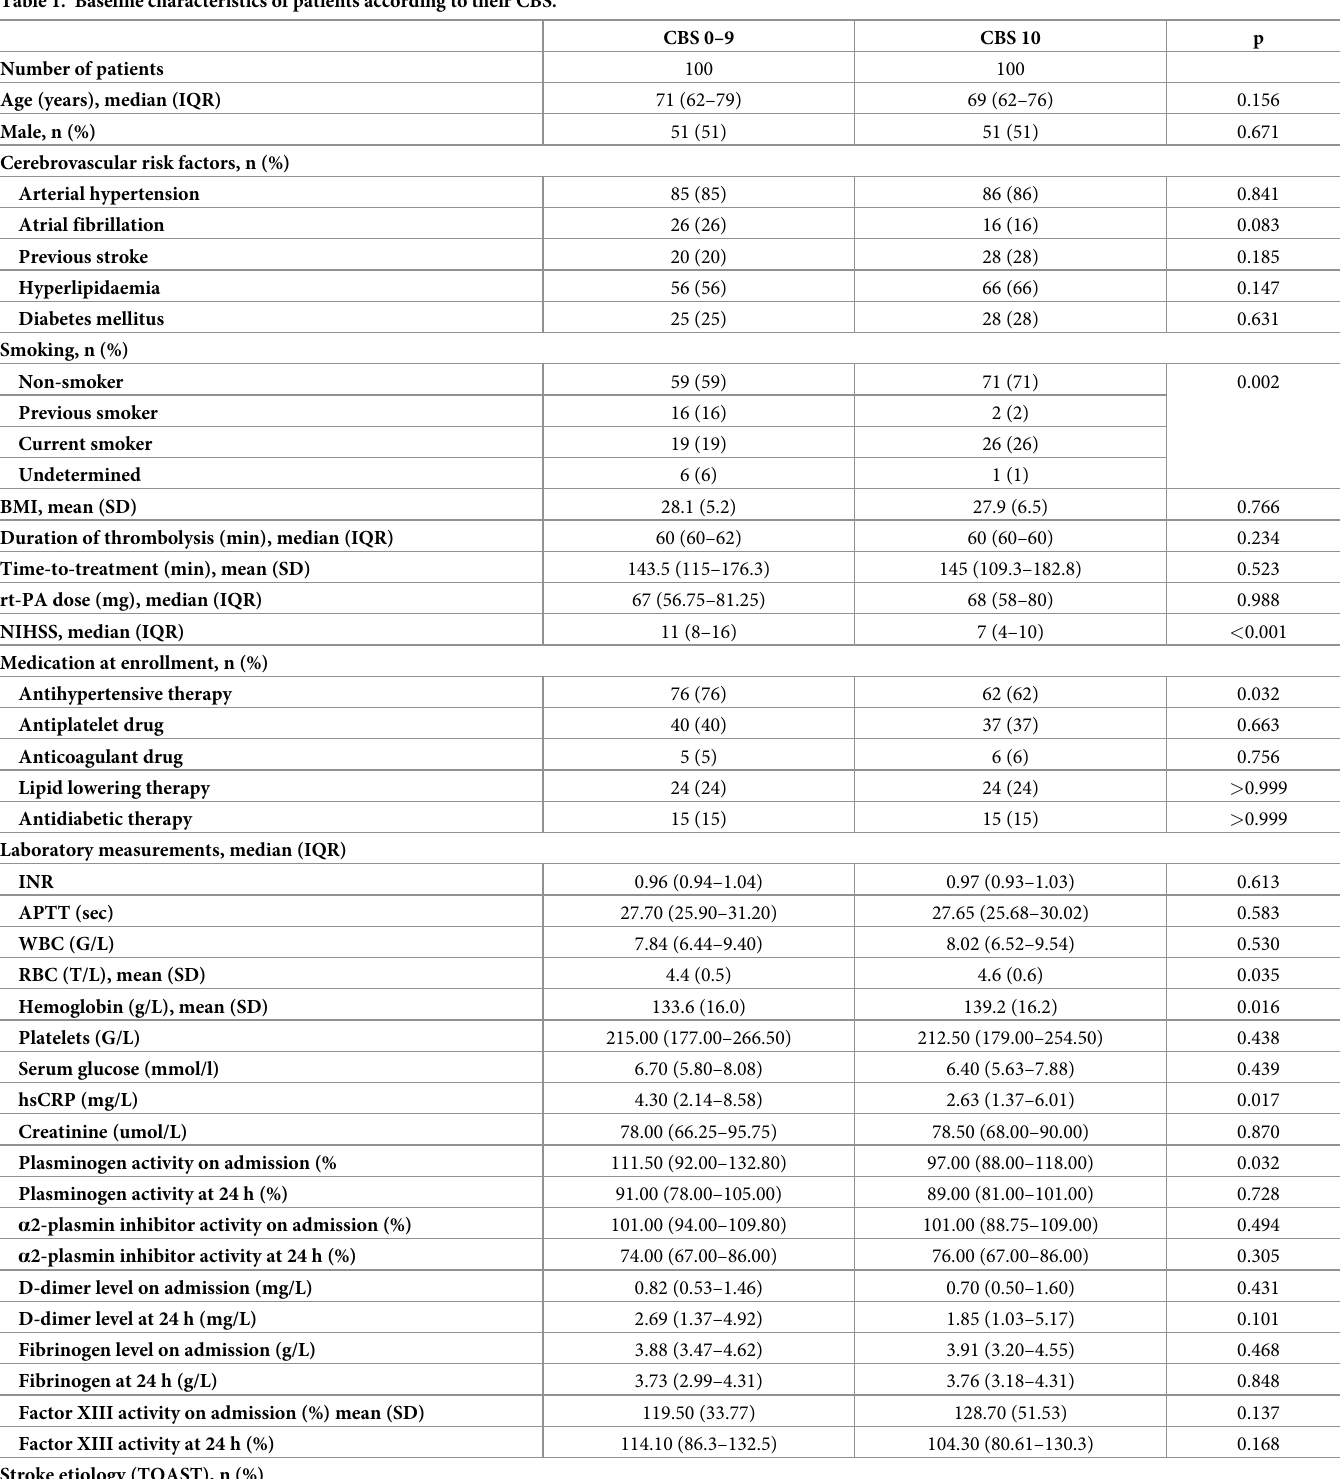
Table 1. Baseline characteristics of patients according to their